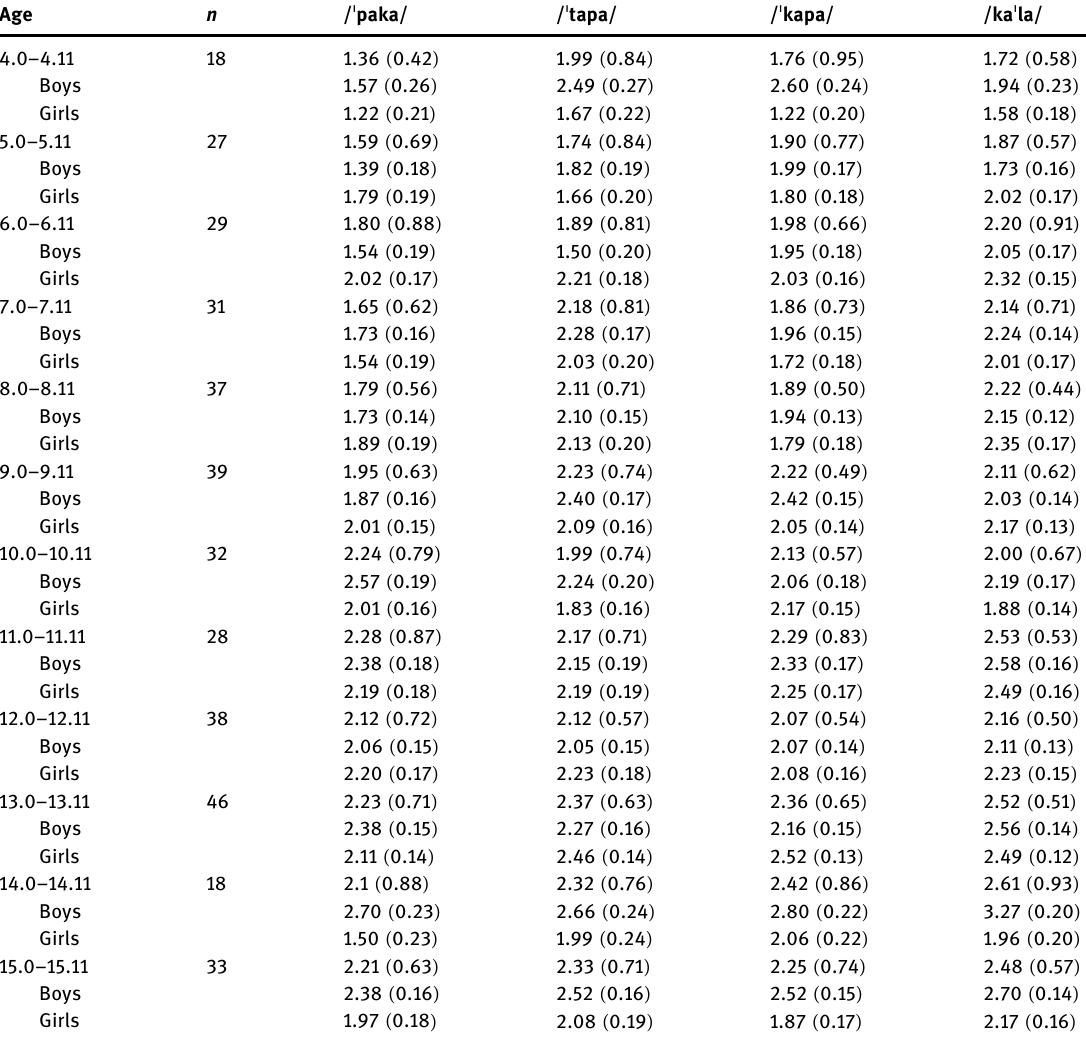
Table A2: Normative data ( mean values ± SDs ) of word stimuli repetition per second